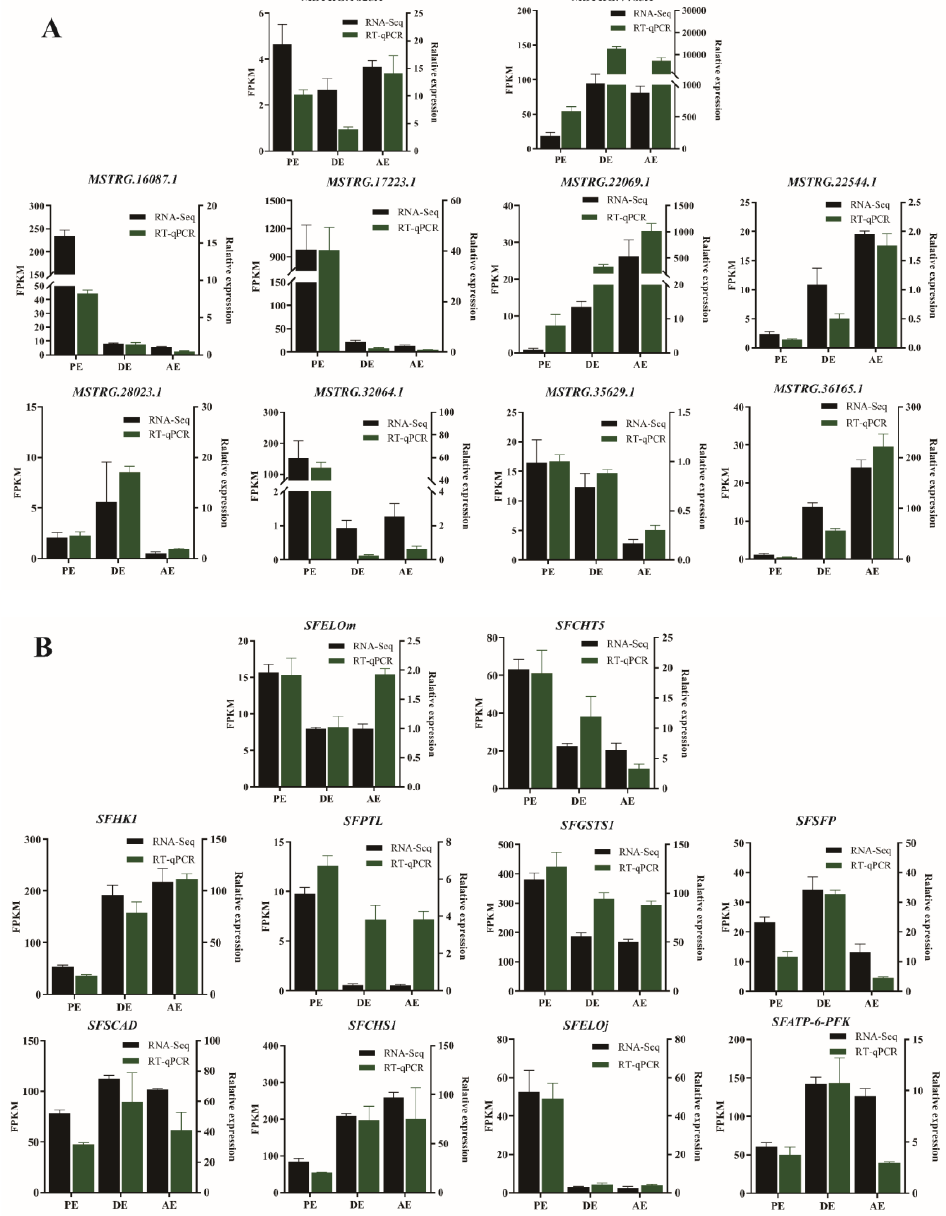
Figure 8. Validation of differentially expressed lncRNAs and mRNAs via RT–qPCR. ( A ) Differentially expressed lncRNA analysis; ( B ) differentially expressed mRNA analysis.